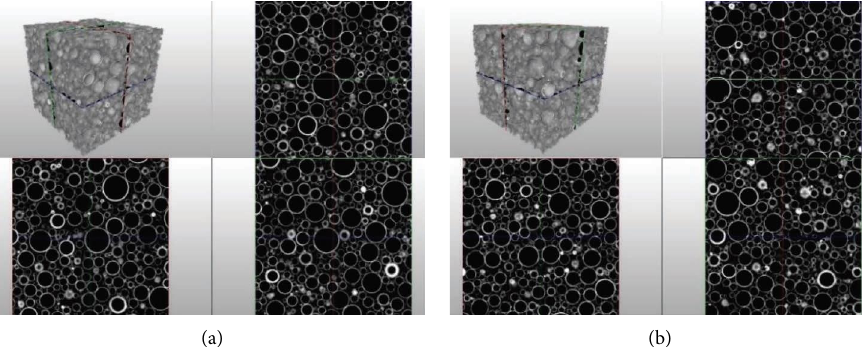
Figure 16: Four views of local data. (a) Before cyclic loading. (b) After cyclic